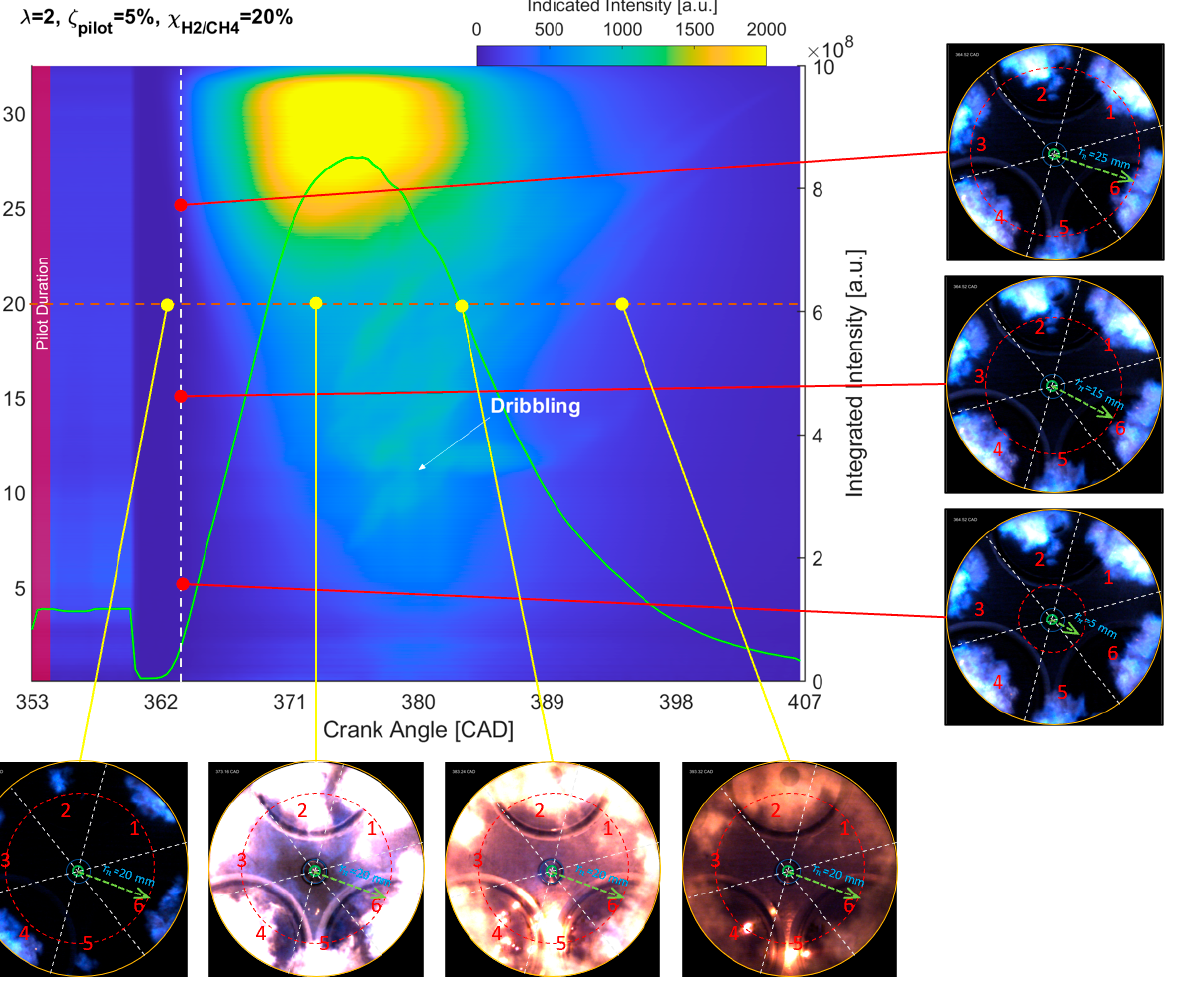
Figure 4. Integrated intensity of axial distance from injector tip I ( r n , CAD ) over 25 individual combustion cycles. Left: example of the integrated intensity of axial distance r n = 5, 15, 25 mm at 364.52 CAD. Bottom: example of the integrated intensity of axial distance r n = 20 mm and crank angle of 363.08 CAD, 373.16 CAD, 383.24 CAD, and 393.32